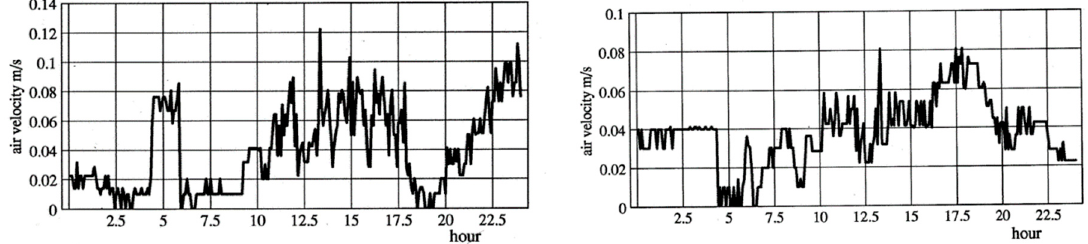
Figure 21. Air velocity distribution at desk height ( left ) and ankle height ( right ) [41].